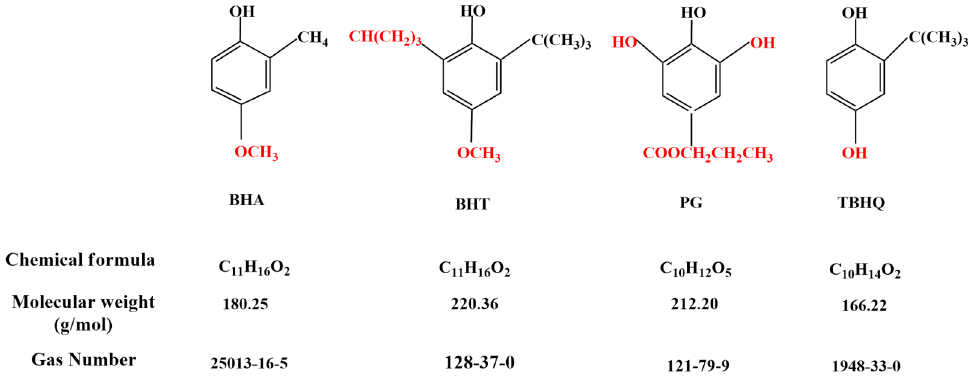
Figure 11. Chemical structures of butylated hydroxyanisole (BHA), propyl gallate (PG), tertiary butylhydroquinone (TBHQ), and butylated hydroxytoluene (BHT). The red color represents the differences in the chemical structure of BHA, BHT, TBHQ, and PG.